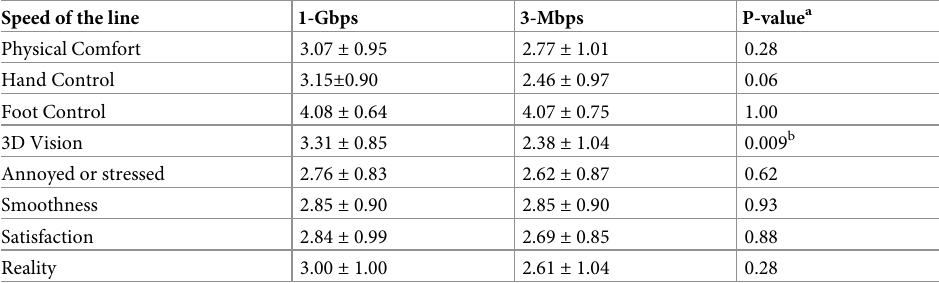
The evaluation of the stereoscopic view was significantly lower for the 3-Mbps line than in the 1-Gbps line. There was no statistical difference of the score in the other parameters. a p values were calculated using the paired t- test. b p < 0.05.